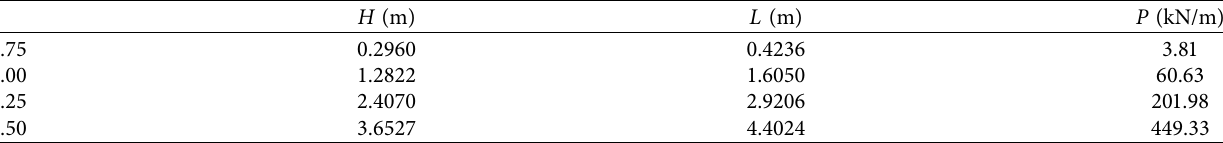
Table 6: Dimensions of collapsing block varied with tunnel radius r.